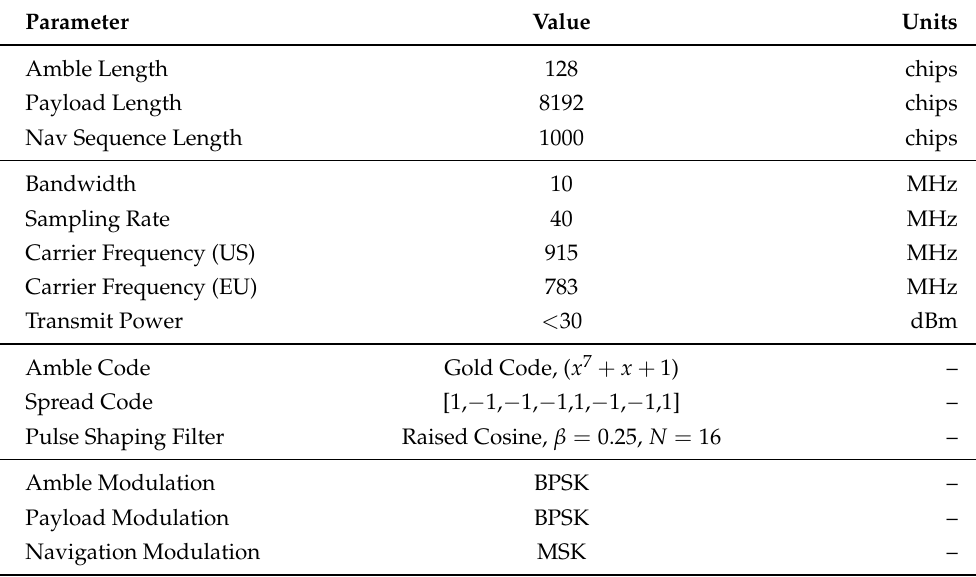
Figure 5. Depiction of the transmissions sent from each antenna for a single transmit frame. The current implementation only uses one antenna for the communications tasks but future implemen- tations will use all available antennas to enable MIMO capabilities. The navigation sequences are transmitted from each antenna following a simple tim-division strategy. Table 2. CHP2 prototype waveform